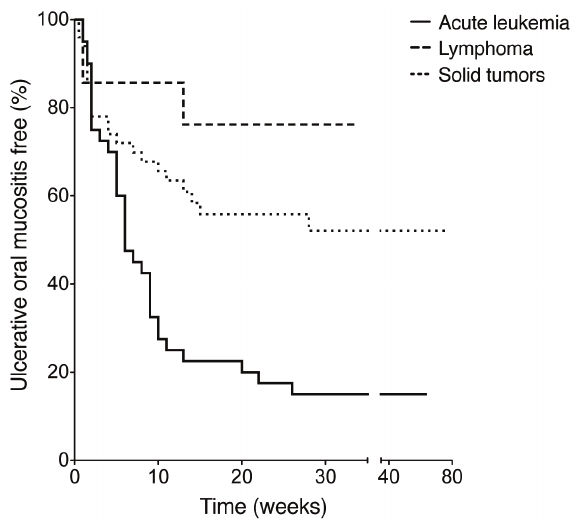
Figure 1. Kaplan-Meier curve of patients free from ulcerative oral mucositis with different types of malignancies. The horizontal axis starts from the beginning of the entire chemotherapy protocol. The oral mucositis (WHO grade . 1) free rate is lower in patients with acute leukemia compared to those with lymphoma ( P =0.001) or solid tumors ( P =0.001). The oral mucositis free rates are not different between patients with lymphoma and those with solid tumors ( P